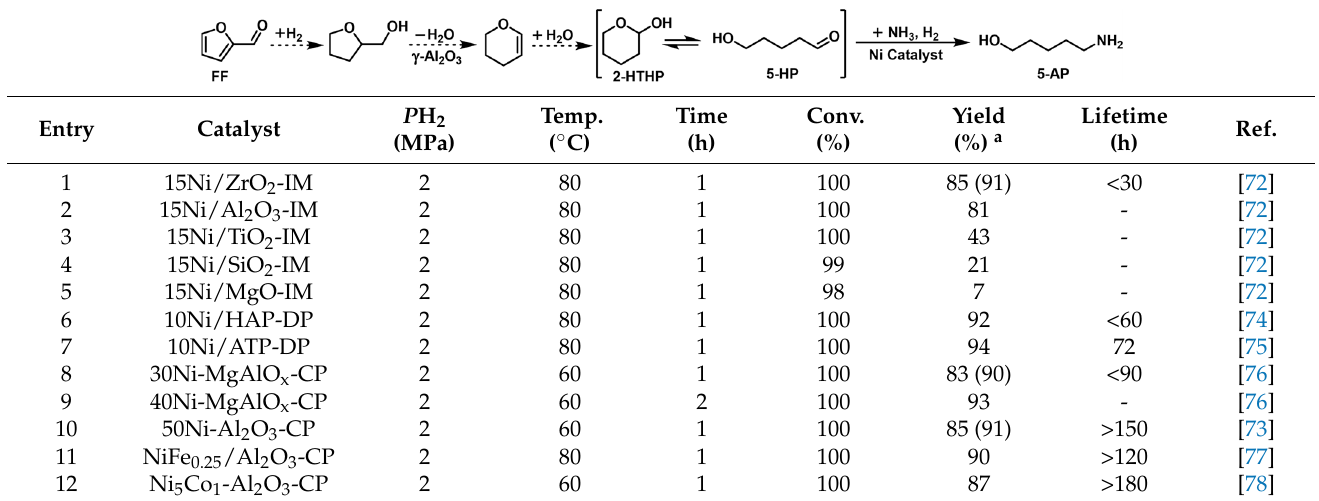
Table 3. Reductive amination of FF-derived 2-HTHP with NH 3 .